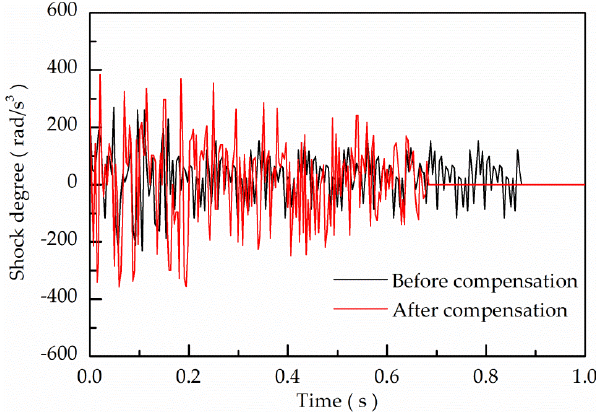
Figure 10. Comparison of shock degree before and after compensation.